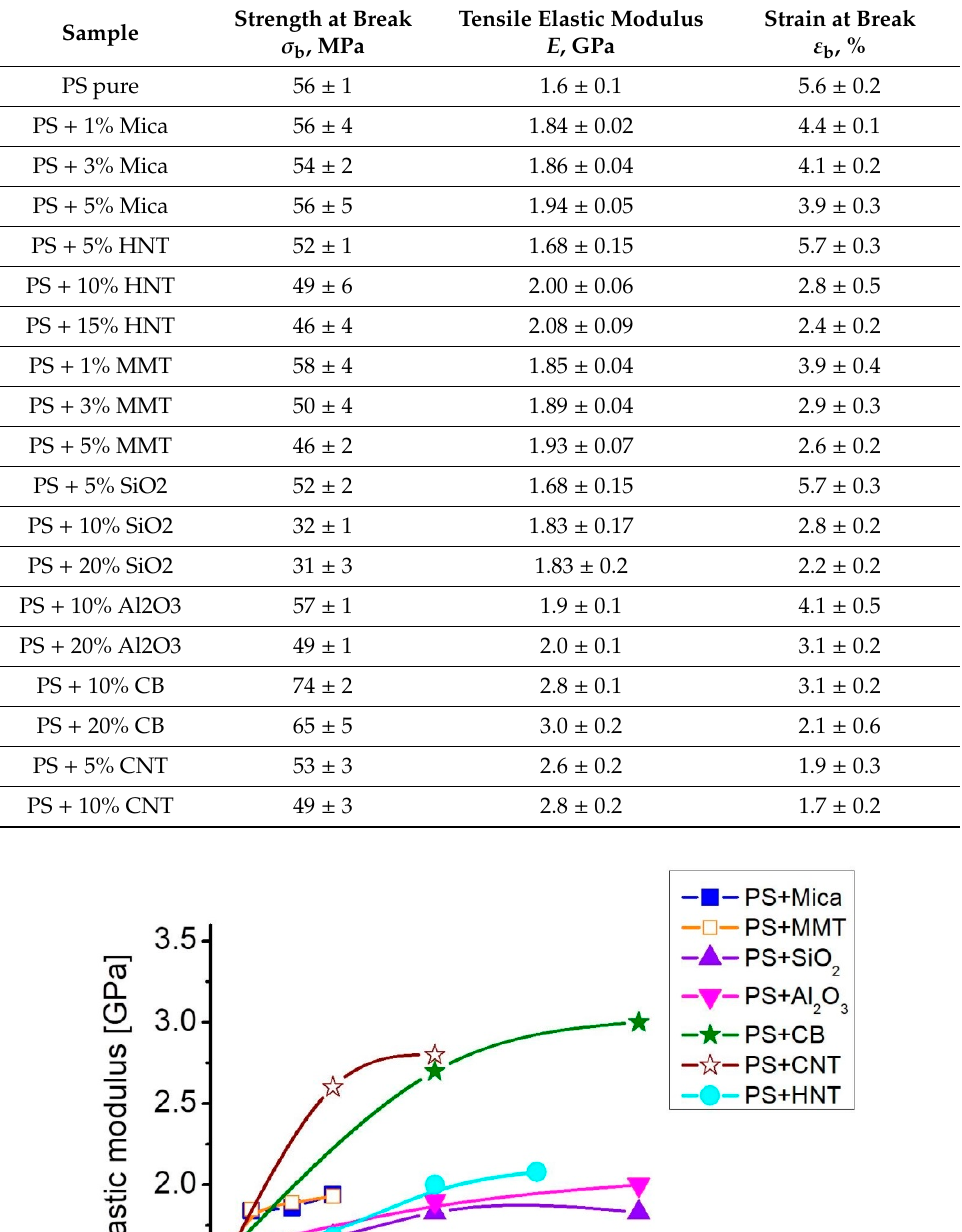
Table 3. Mechanical properties of PS-based composites with different fillings.